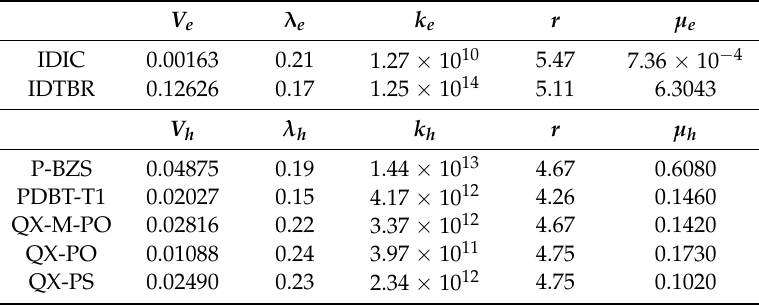
Table 8. The key parameters related to drift mobility of NFAs (IDIC and IDTBR) and the five polymers: V e / V h (eV), λ e /λ h (eV), r (Å ), K e / K h (s −1 ) and μ e / μ h (cm 2 /(V·s)).